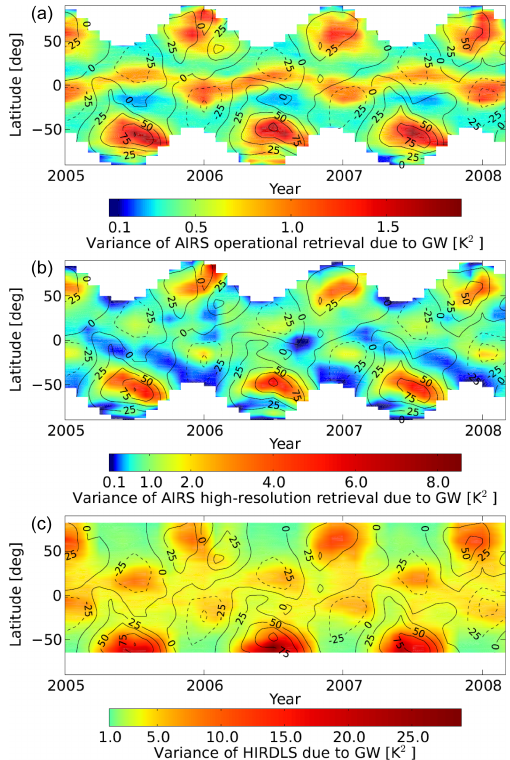
Figure 11. Same as Fig. 10 but for